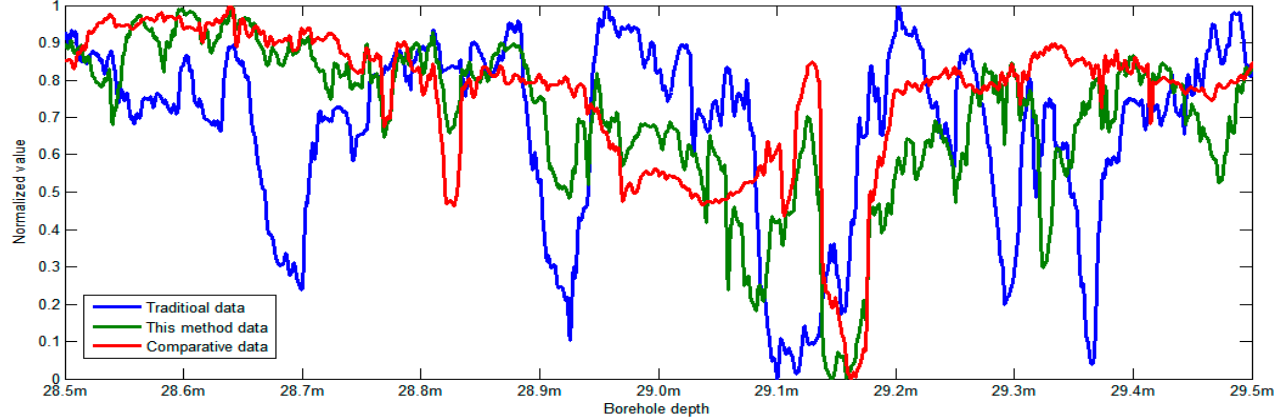
Figure 16. Numerical comparison of different methods.